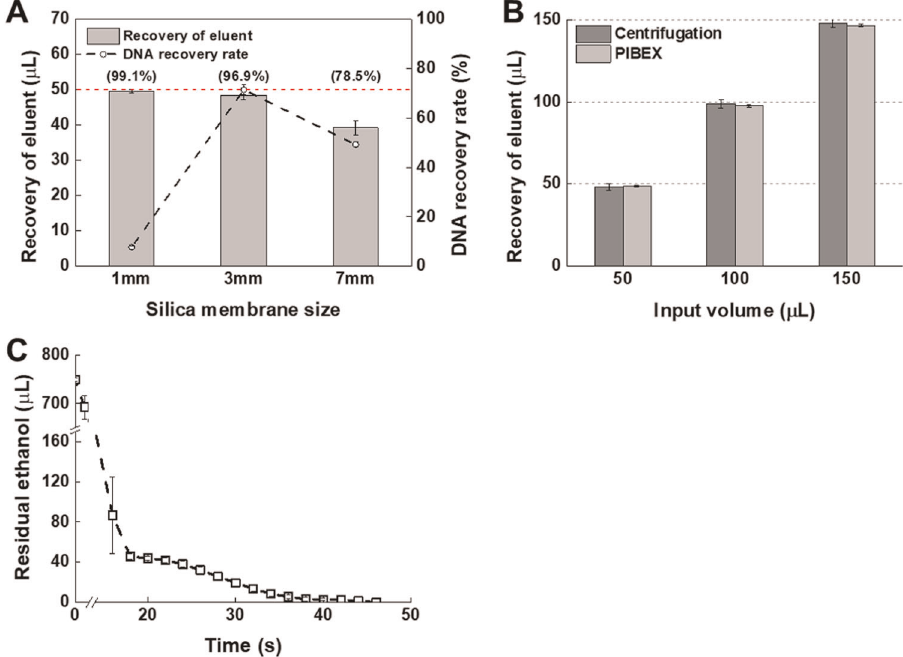
Fig. 2 Characteristic analysis of a micro fl uidic PIBEX chip. Eluting, pushing with oil, and drying steps were optimized for the PIBEX application in a micro fl uidic chip. a Membrane size effect on recovery volume of eluent (bar chart) and DNA recovery rate (dotted line) in the PIBEX method were investigated ( n = 3). The target initial volume of eluent was 50 μ L. The numbers in parentheses denote the percentage of eluent recovery. b Recovery amount of eluent were investigated in centrifugation, vacuum only, and PIBEX chip methods ( n = 3). Initial eluent volume varies from 50 – 150 μ L. c Residual ethanol remaining inside silica membrane was monitored in pressure-driven air fl ow ( n = 3). The error bars indicate standard